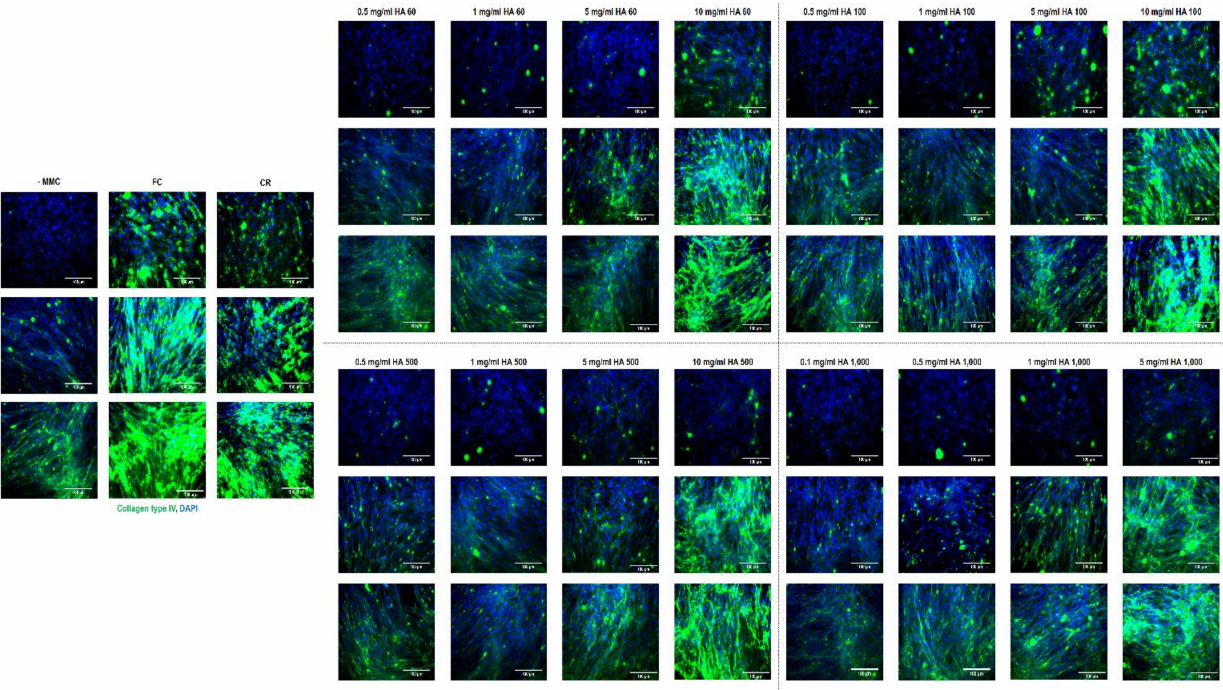
Figure 4. Immunocytochemistry analysis revealed that Ficoll ® induced the highest collagen type IV deposition at all timepoints and at day 8 (longest timepoint assessed), the carrageenan, the 10 mg/mL HA 60 kDa, the 10 mg/mL HA 100 kDa, the 10 mg/mL HA 500 kDa and the 5 mg/mL HA 1000 kDa induced significantly higher collagen type IV deposition than the non-MMC